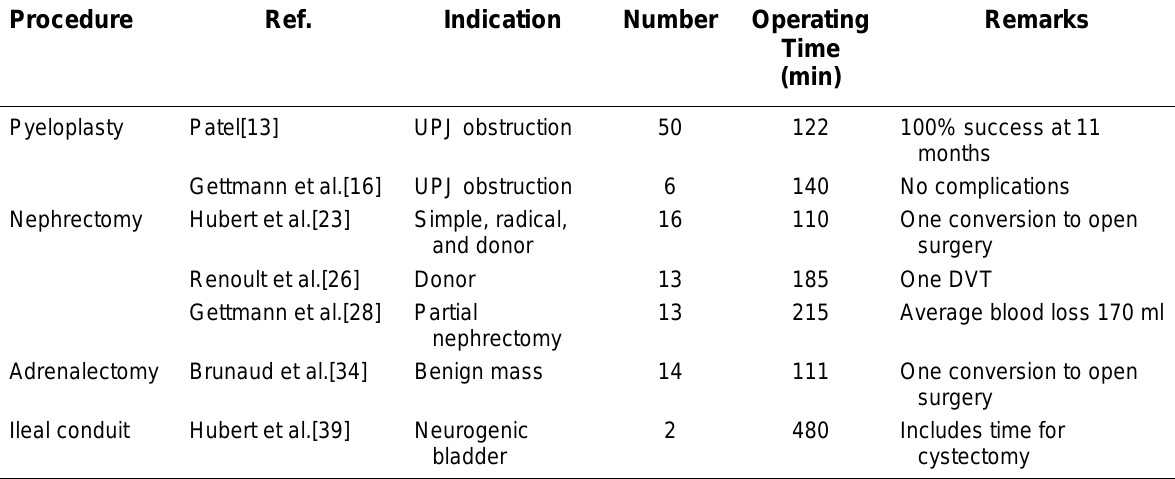
Robotic-Assisted Surgery for Benign Urological